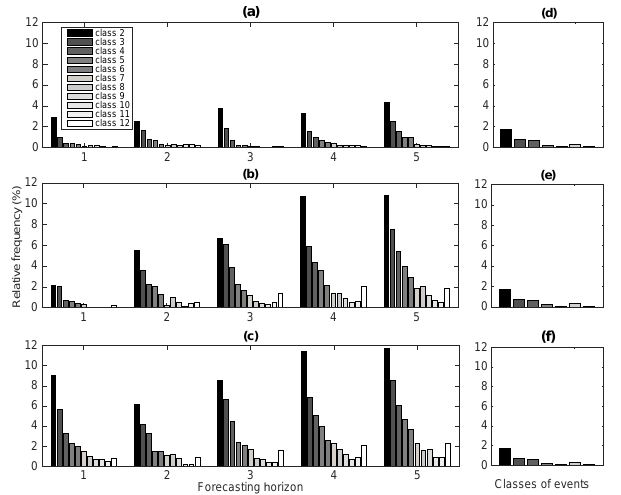
Figure 11. Relative frequencies of forecasts and observations corre- sponding to the classes of events used in the evaluation of damages, as a function of the forecasting horizon (1 to 5 days). (a) Dressed de- terministic forecasts, forecasts based on meteorological ensembles without (b) and with (c) EnKF. Panels (d) , (e) and (f) are identical and show the relative frequencies of the observations for the same